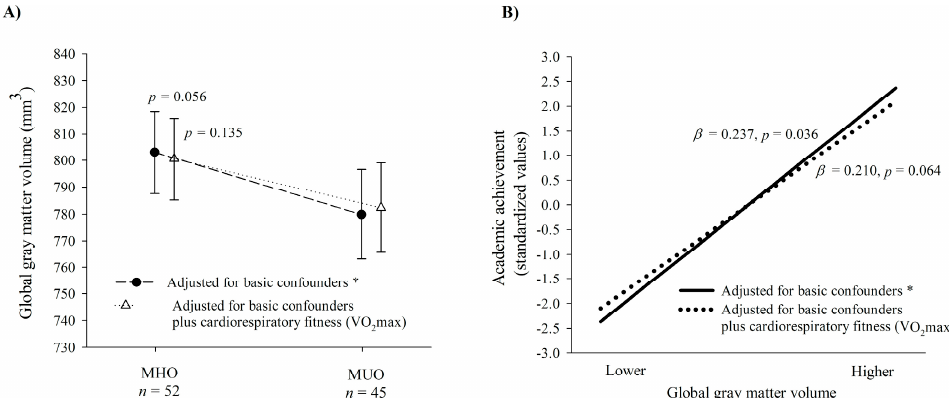
Figure 1. Differences in global gray matter between metabolically healthy and metabolically unhealthy overweight/obesity (Panel A ) and associations between global gray matter and academic achievement (Panel B ). β : beta standardized coefficients. MHO: Metabolically healthy overweight/obesity. MUO: Metabolically unhealthy overweight/obesity. VO 2 max: maximum oxygen consumption. * Basic confounders were sex, peak height velocity (Panel A) or age (Panel B), parental education level (none/one/both of them), and body mass index (kg/m 2 ).